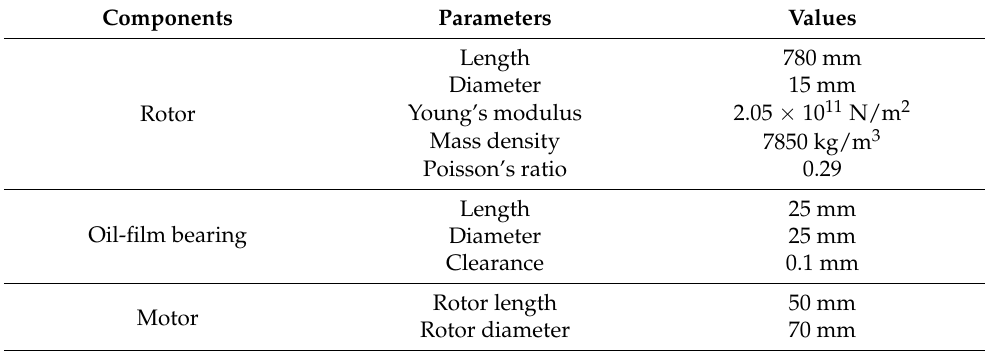
Table 2. Specifications of the rotor system.